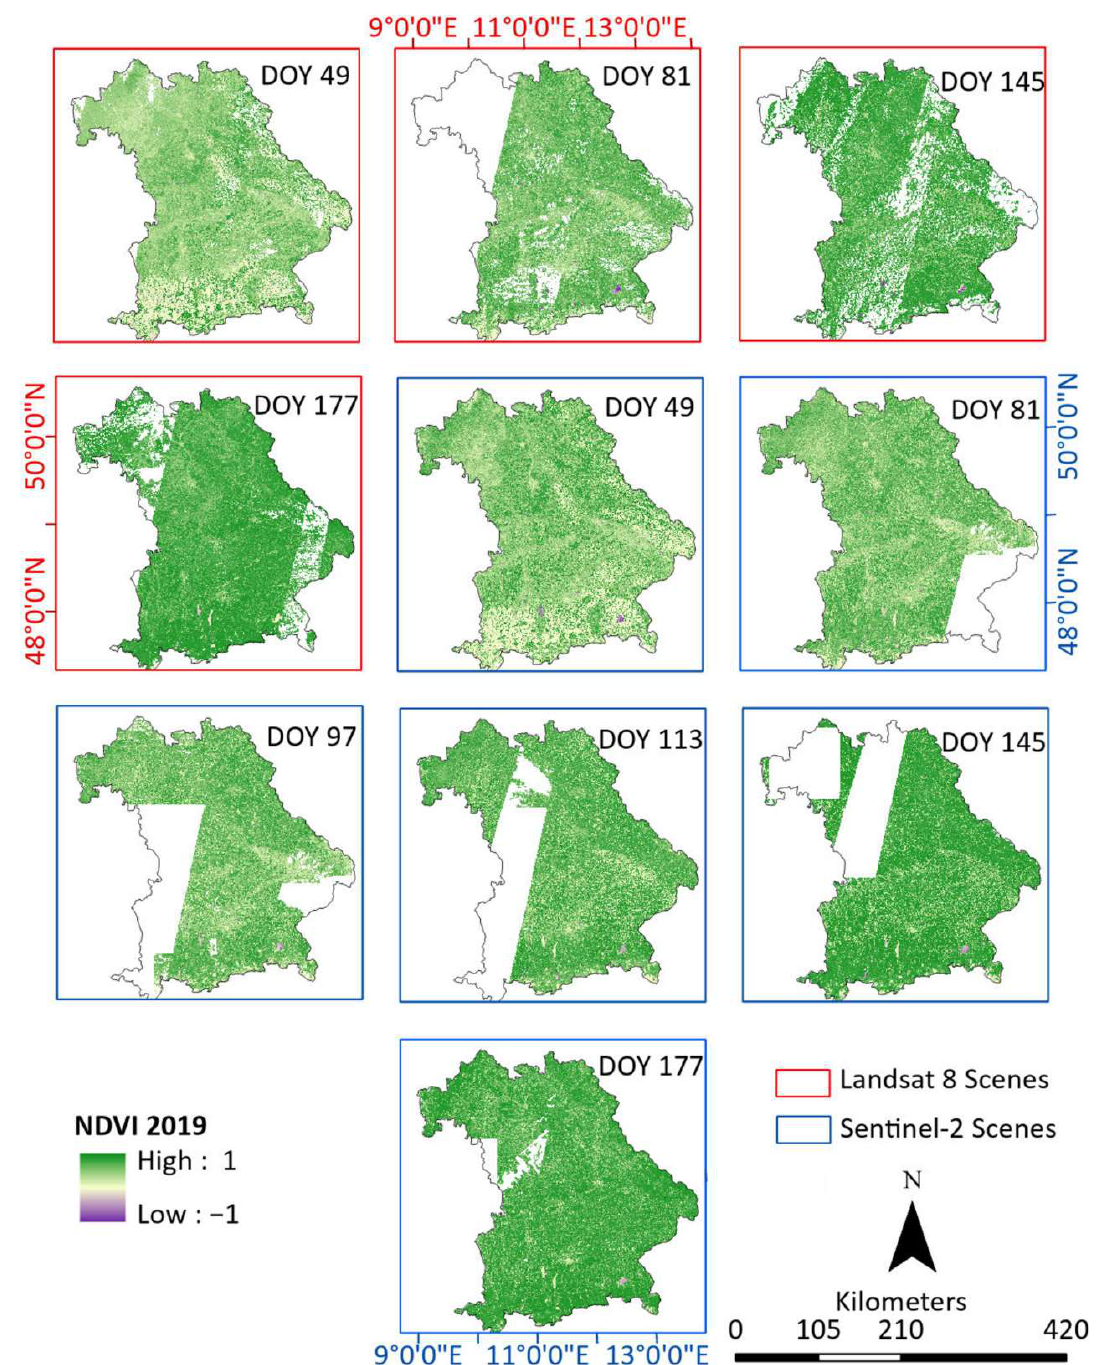
Figure 3. The cloud-free scenes are available for Landsat (in red box) and Sentinel-2 (in blue box) during the seasons of OSR and WW. Four cloud-free scenes were collected for the Landsat data and six were collected for the Sentinel-2 data. The maps show the NDVI values from −1 to 1 for Bavaria during 2019. The negative NDVI values indicate non-vegetated areas such as water bodies or barren land.